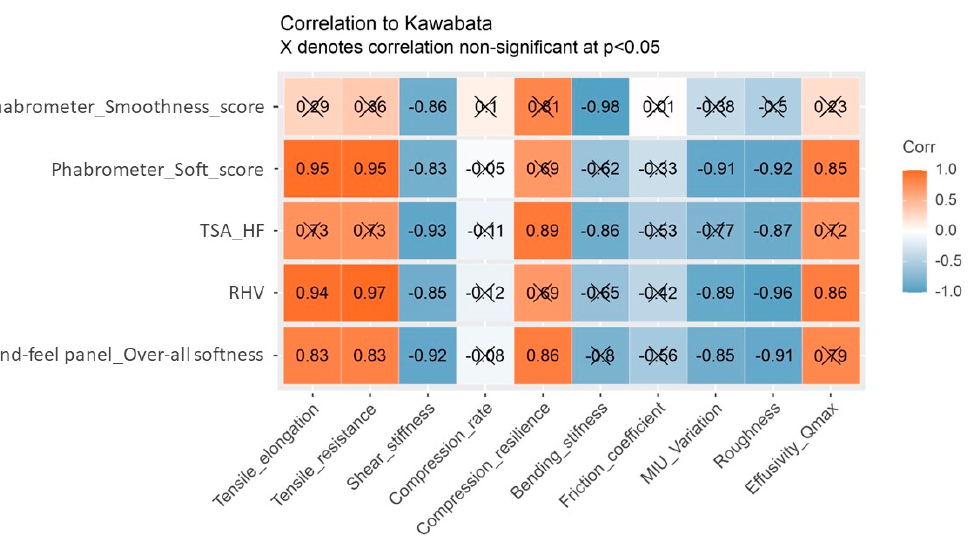
Figure 6. Pearson correlation of “softness” values from the hand-feel panel, Phabrometer, and TSA with Kawabata parameters (for knitted fabrics).